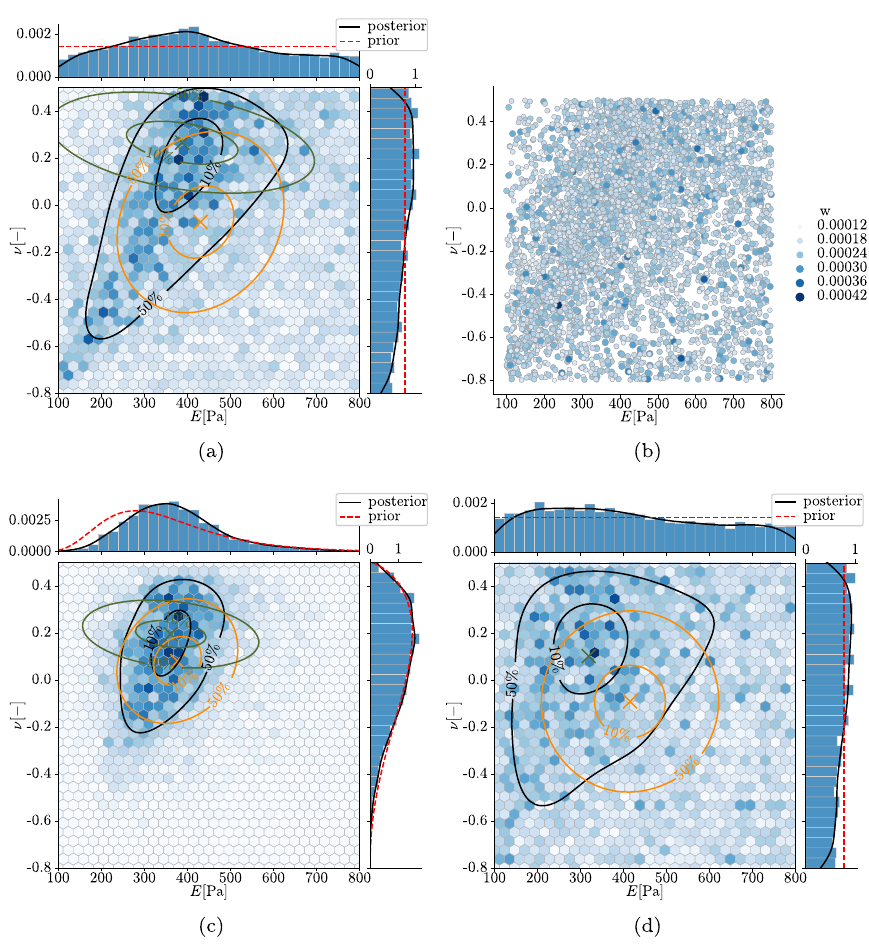
(cid:3) (cid:2) in histograms. Two-dimensional hexagon E, ν | Y obs ,C (cid:2) (cid:3) (cid:2) (cid:3) ν | Y E | Y obs ,C and p attached to top and obs ,C